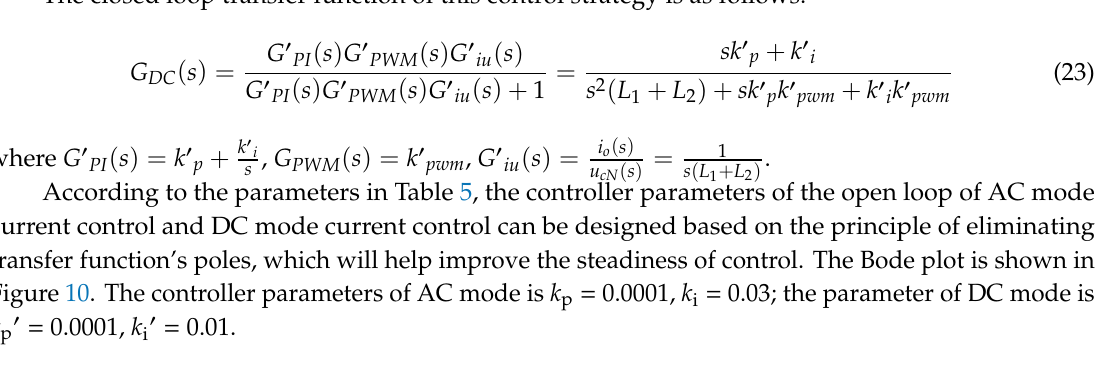
Table 5. PR Simulation Parameters.